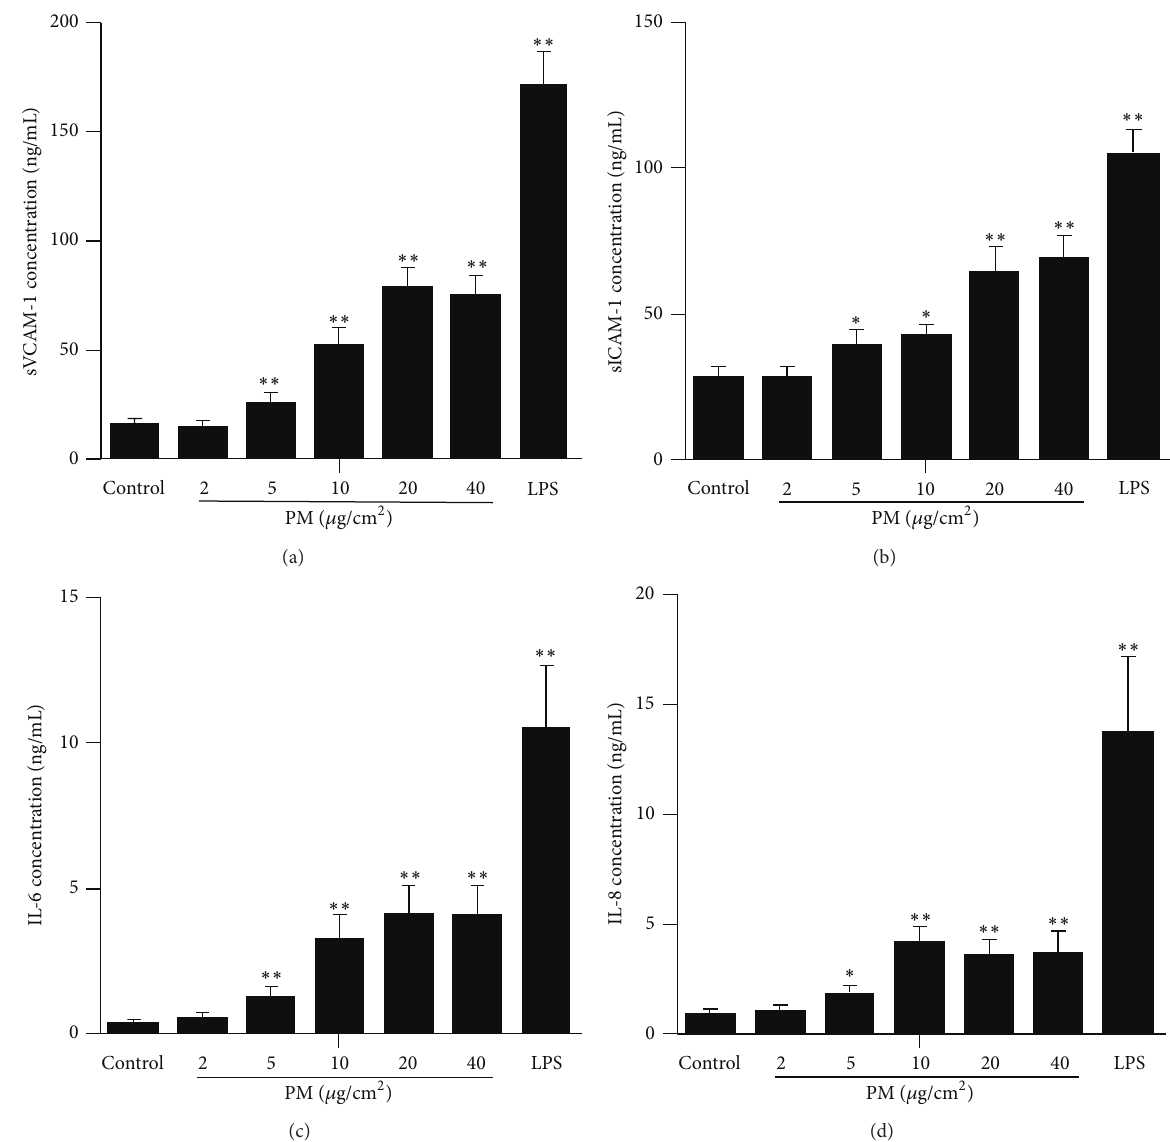
Figure 2: PM induces HUVECs inflammatory responses in a concentration-dependent manner. HUVECs were treated with graded concentration (2, 5, 10, 20, and 40 𝜇 g/cm 2 ) of suspension of the particles for 24 h and the supernatant was collected. The concentration of sVCAM-1 (a), sICAM-1 (b), IL-6 (c), and IL-8 (d) was detected by Elisa. ∗ indicates PM or LPS versus control. ∗ 𝑃 < 0.05 ; ∗∗ 𝑃 < 0.01 . Experiments were repeated 3